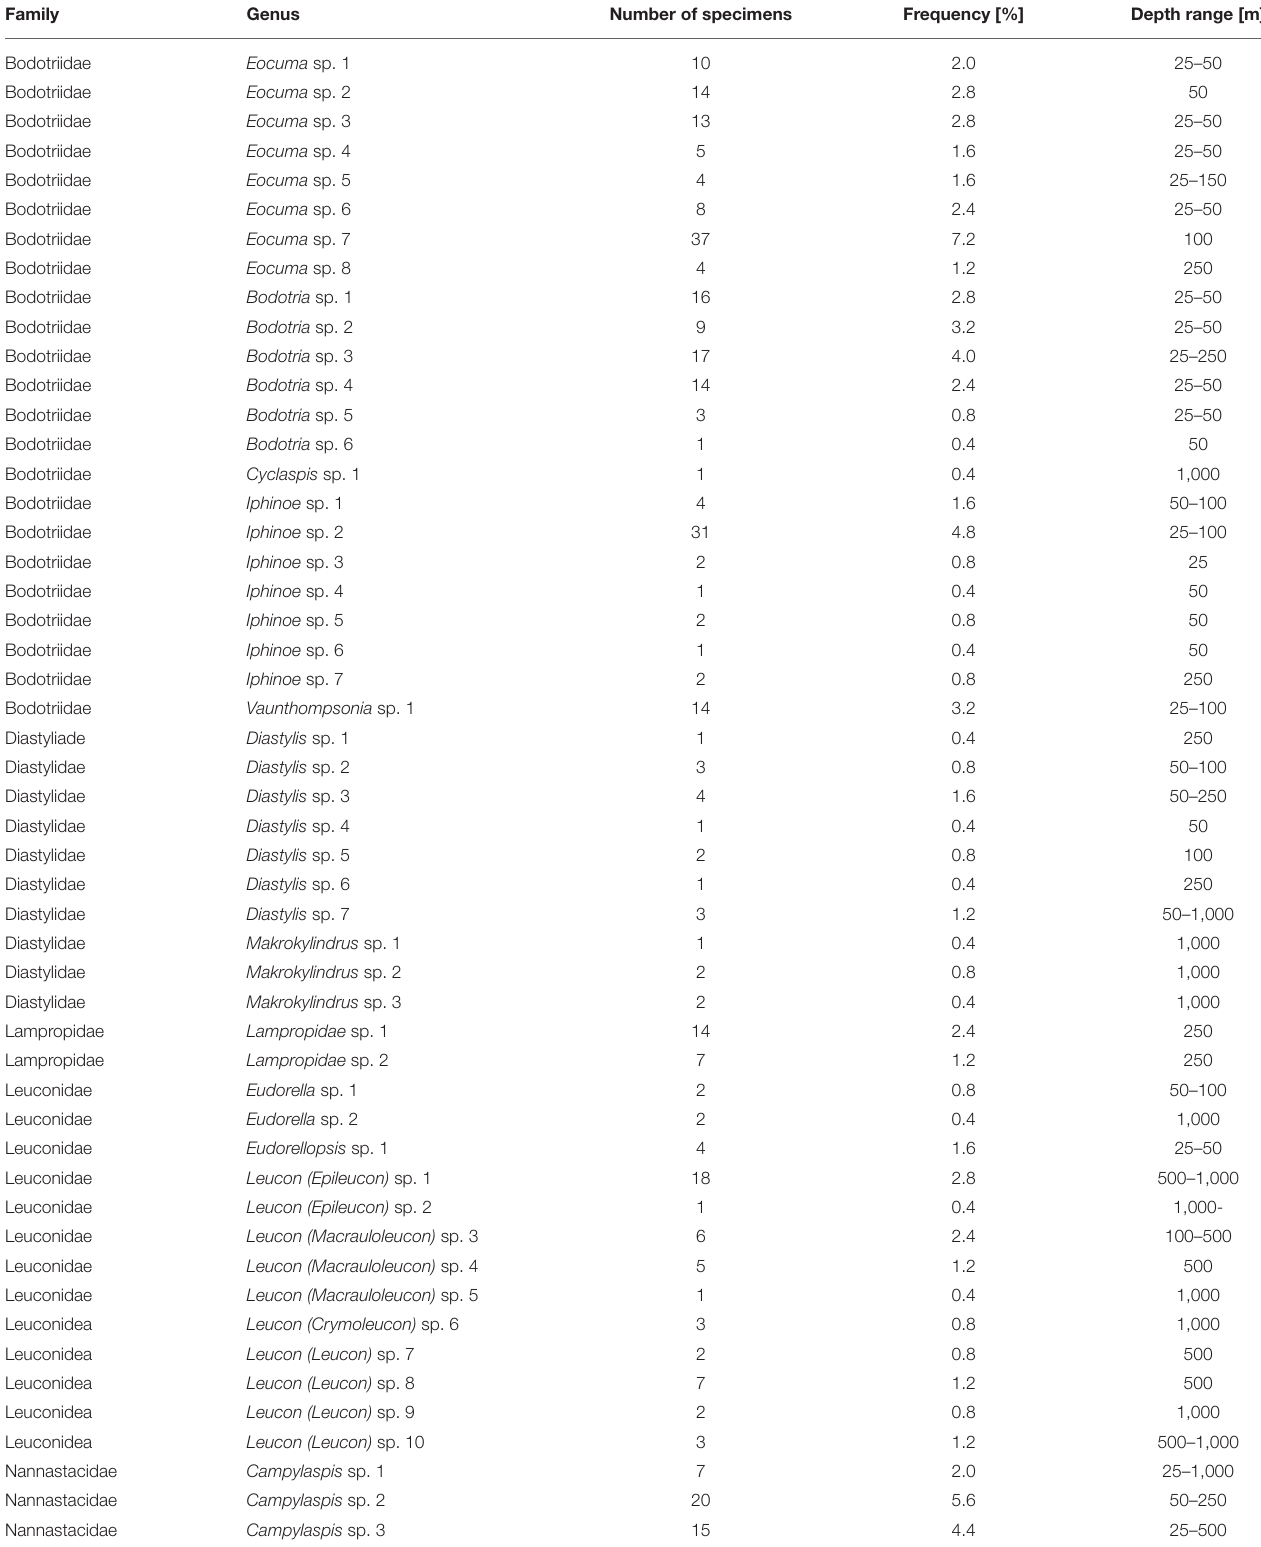
TABLE 1 | List of species with total abundance, frequency of occurrence in samples, and depth range.